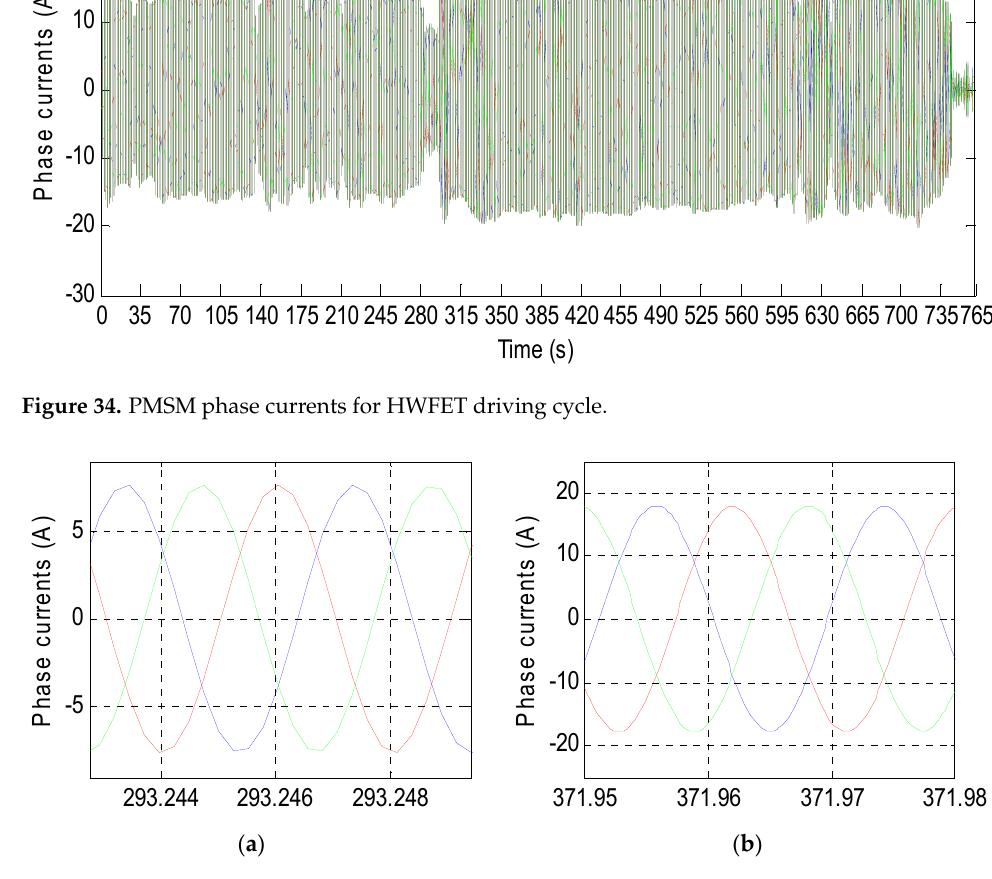
Figure 35. BEV torque response and its reference for HWEFT driving cycle.